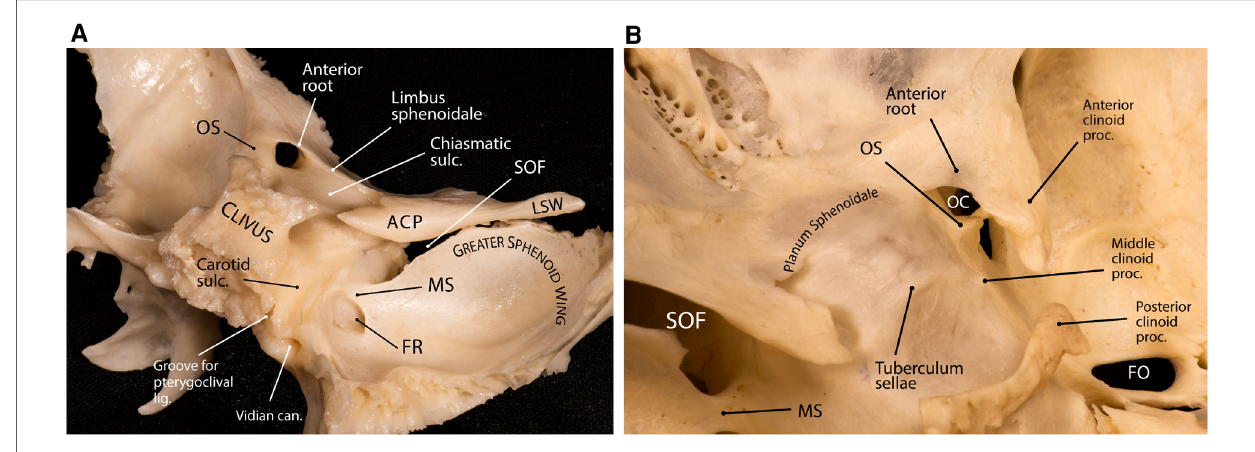
FIGURE 2 Anatomy of the anterior clinoid process. ( A ) Lateral posterior view of the sphenoid bone showing the relationship between the sphenoid wings, anterior clinoid and the sellar region. The superior orbital fi ssure is the cleft between the lesser and greater sphenoid wings. ( B ) Superior view of the central skull base and middle fossa. Note the interrelationship of the anterior clinoid roots. The tips of the anterior and middle clinoid processes partially encircle the internal carotid artery and may form a carotico-clinoid foramen around the carotid artery. ACP, anterior clinoid process; can., canal; FO, foramen ovale; FR, foramen rotundum; lig., ligament; LSW, lesser sphenoid wing; MS, maxillary strut; OC, optic canal; OS, optic strut; proc., process; SOF, superior orbital fi ssure; sulc., sulcus. (Copyright Ali Tayebi Meybodi. Used with